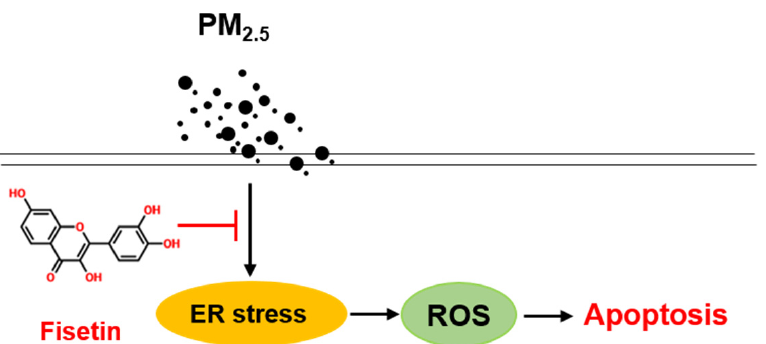
Figure 5. Fisetin prevents PM 2.5 -induced apoptosis in HaCaT keratinocytes by inhibiting endoplas- mic reticulum (ER) stress-mediated reactive oxygen species (ROS) production.